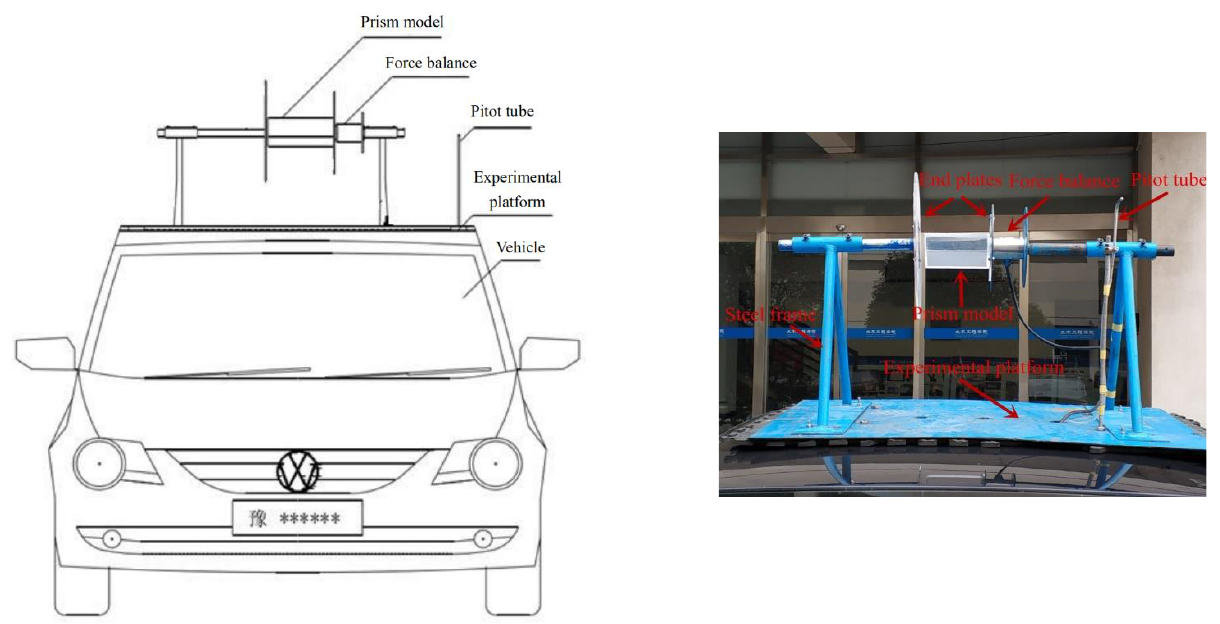
Figure 2. Test devices of transiting test for aerodynamic coefficient measurements on top of the testing vehicle.